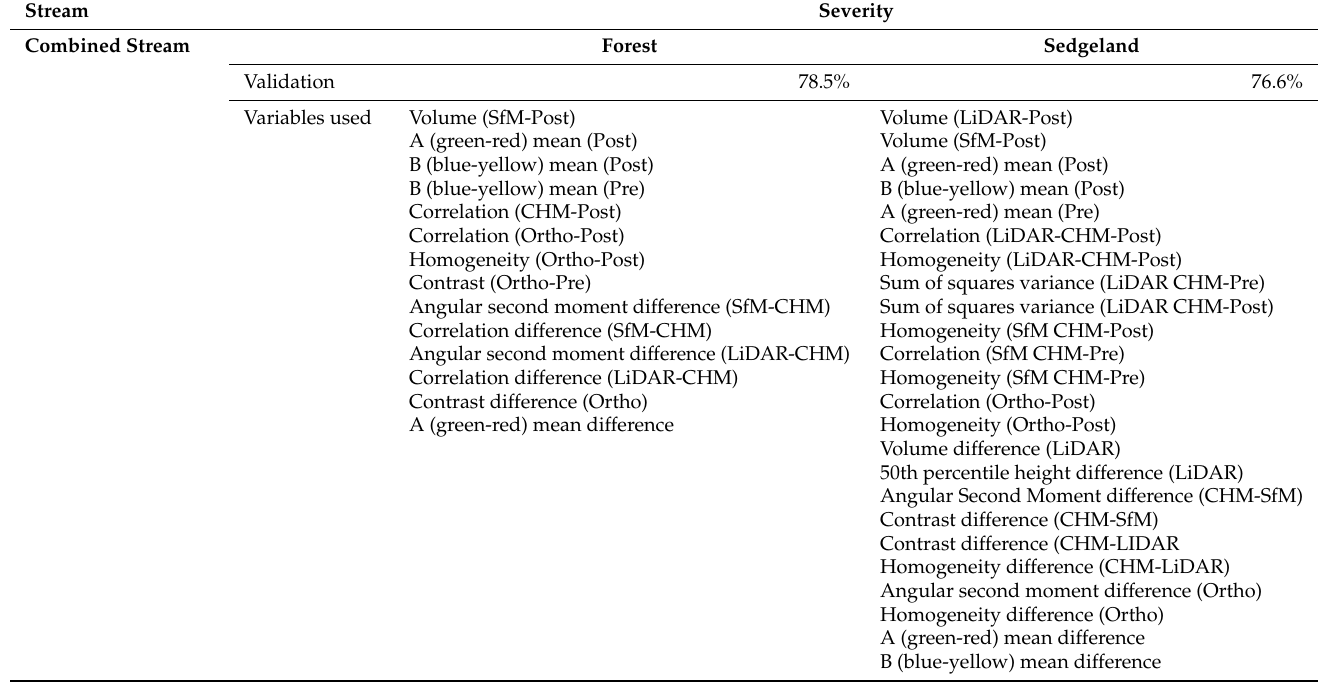
Table A4. Summary of accuracy derived from the validation dataset and predictor variables used in Combined